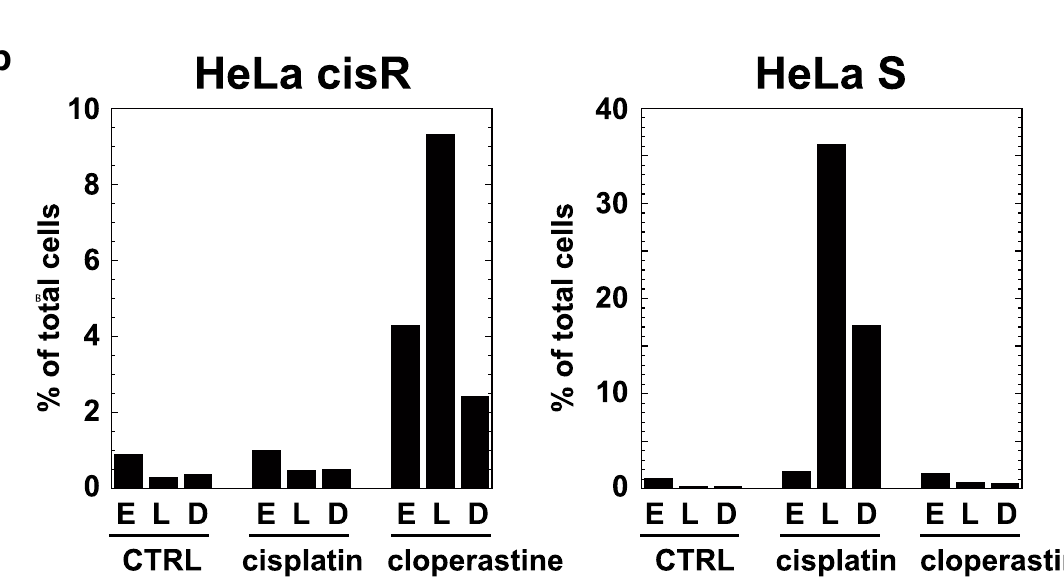
Figure 7. Cloperastine increases the HeLa cisR cell fraction undergoing apoptosis/cell death. ( a ) Flow cytometric analysis of cell death. Growing HeLa cisR and HeLa S cells were cultured for 24 h in their respective growth media (control) or in medium containing 1 µg/ml cisplatin or 100 µM cloperastine. The cells were stained with Annexin V-FITC and PI, and the intensities of the FITC and PI fluorescences were analyzed using a flow cytometer and plotted. In each panel, the bottom left section represents Annexin V LOW PI LOW (live) cells, the bottom right section Annexin V HIGH PI LOW cells (early phase apoptosis), the top right section Annexin V HIGH PI HIGH cells (late phase apoptosis), and the top left section Annexin V LOW PI HIGH cells (plasma membrane disintegration). ( b ) Relative cell numbers in each phase of apoptosis/cell death in panel a were quantified using ImageJ software and plotted as percentages of the total cells. The labels indicate early phase apoptosis ( E ), late phase apoptosis ( L ), and plasma membrane disintegration ( D ) for each cell line and